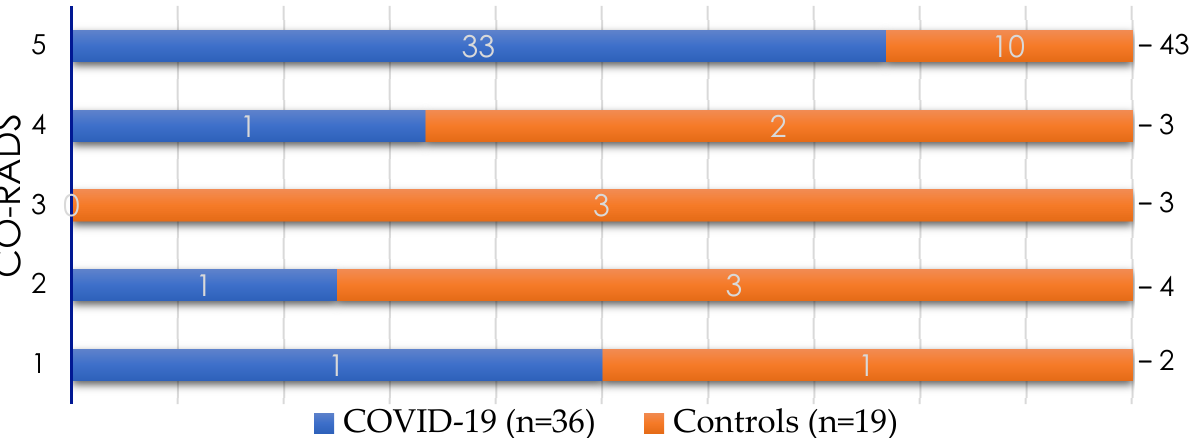
Figure 2. Chest-computed axial tomography (CT) findings according to the COVID-19 Reporting and Data System (CO-RADS) classification. The study population with a negative first SARS-CoV-2 RT-PCR result ( n = 55) underwent a second SARS-CoV-2 RT-PCR. According to this result, they were classified into the COVID-19 group (positive RT-PCR result) or the control group (negative RT-PCR result). At the time of admission, a chest CT was carried out, and the scans were categorized by using the CO-RADS system. The graph shows the number of patients in each group based on their CO-RADS score. Most of the patients in the COVID-19 group were classified as CO-RADS 5.